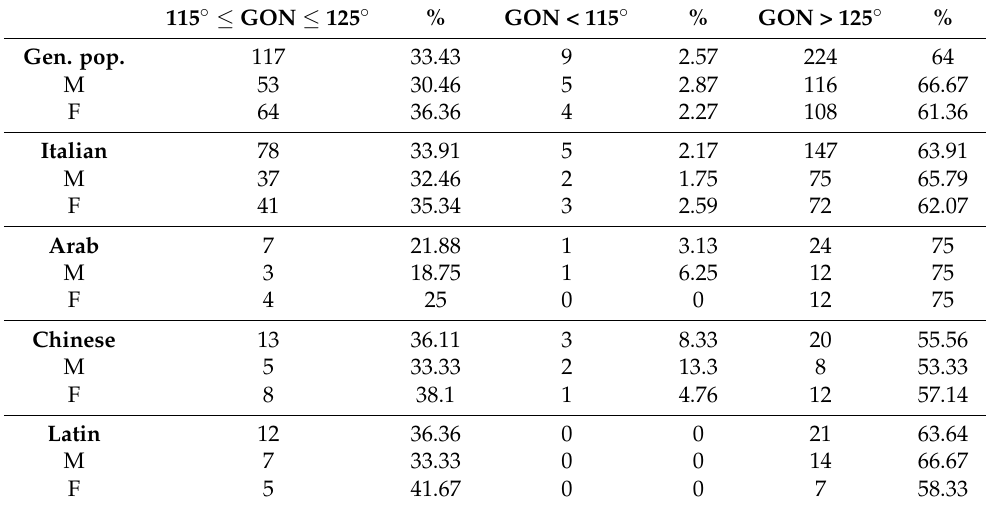
Table 11. Distribution of the total gonial angle values in the selected patient sample.